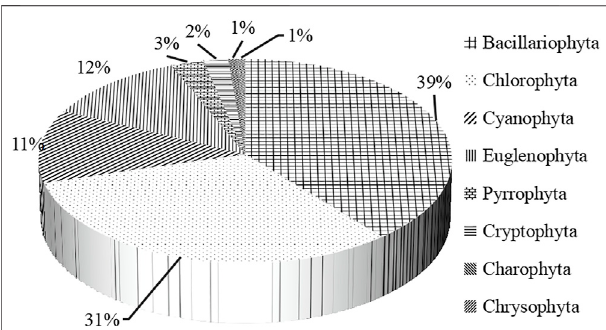
FIGURE 2 | Species composition of